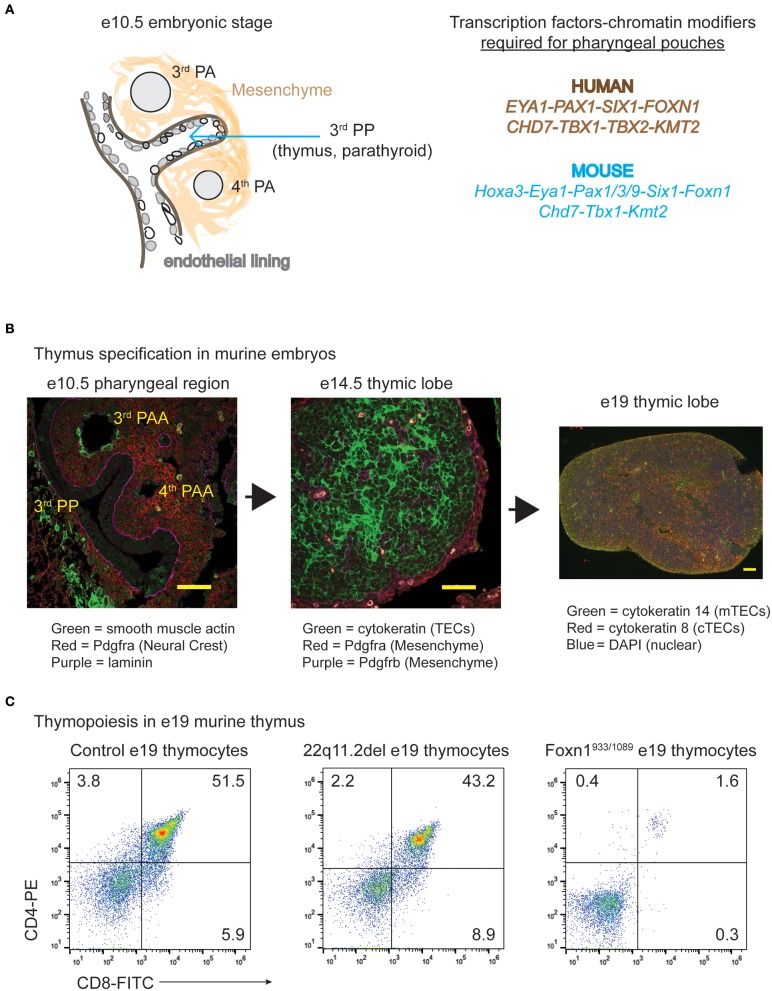
The specification and expansion of the thymus during embryogenesis in normal and disease states. (A) Cartoon diagram illustrating the development process of the thymus along with the various transcription factors and gene products required. The genes that have roles in the specification of the human pharyngeal apparatus that affects the 3rd pharyngeal pouch (thymus and parathyroid) are shown in brown, while those confirmed importance for these processes in mice are in blue. (B) Transverse tissue sections or intact thymic lobes were isolated from normal embryos at the indicated ages of gestation. The transverse sections or whole mounts of the tissue were prepared for immunohistochemistry and H&E staining. Antibodies against vascular smooth muscle, pdgfr-a (alpha) marking the mesenchymal cells and thymic capsule, pdgfr-b (beta) delineating mesenchymal cells and the vasculature, cytokeratin (TECs) and laminin were used, with the colors indicated below the image. (C) Thymocyte subset distributions present in e19–19.5 embryonic thymuses from control C57BL/6 mice, those modeling 22q11.2 deletion syndrome (Tbx1neo2/neo2) and those with compound heterozygous mutations in Foxn1 (Foxn1933/1089) are shown. The Foxn1 mutations genocopy that identified in a human patient (22). Both control and 22q11.2del thymuses have similar distributions of CD4 and CD8 thymocyte subset percentages, suggesting normal TEC functions. The Foxn1 mutant mice are blocked at the CD4−CD8− subset, indicating a severe TEC dysfunction.